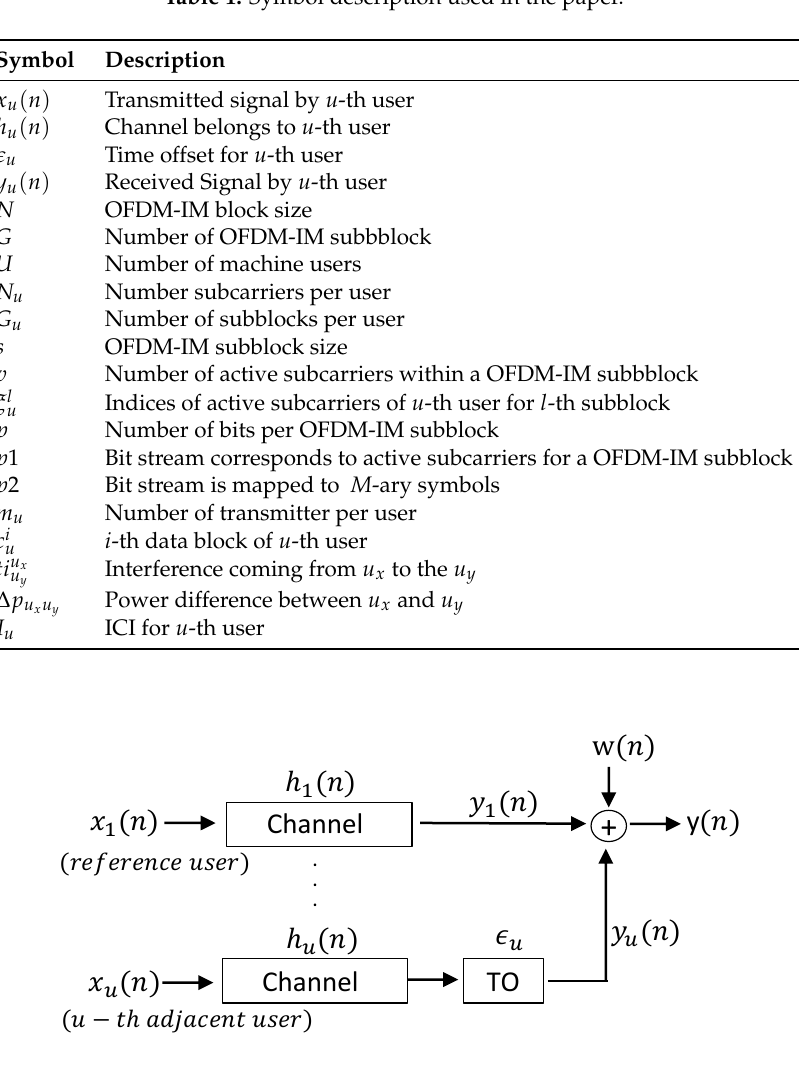
Table 1. Symbol description used in the paper.